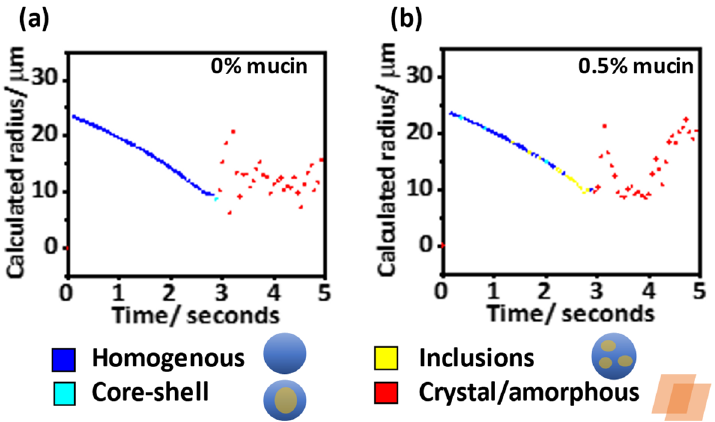
Figure 5. Evaporation profile of representative droplets examining the change in radius and phase morphology over five seconds with a time resolution of 60 ms. Due to chaotic scattering of light from crystal/amorphous particles, radius estimations at later time (red points) are unreliable. Evaporation of droplets containing ( a ) DMEM, 10% FBS and 0% mucin, and ( b ) DMEM, 10% FBS with 0.5% w/v mucin.